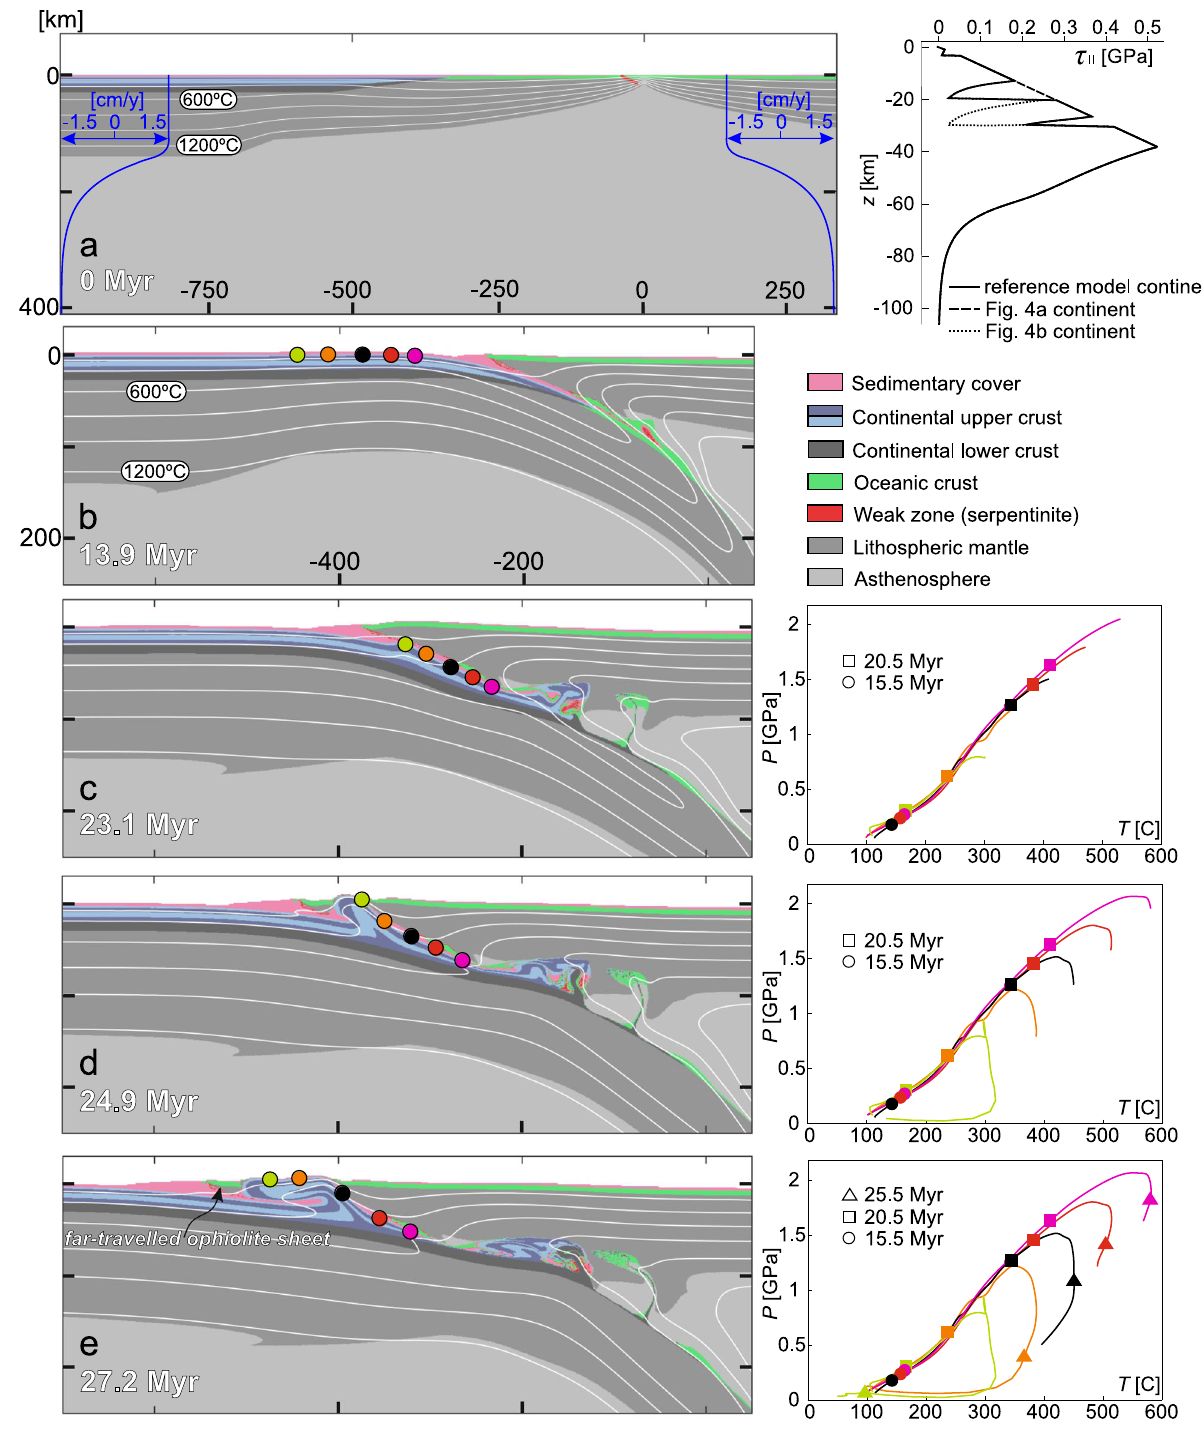
Fig. 2 Model setup and evolution of the reference model. The compositional evolution and associated P-T paths are presented in b – e on the left and right side, respectively. Colored circles are the positions of selected particles for recording P-T conditions and correspond to the colored lines on the left-side P-T diagrams. a Model setup showing the initial distribution of compositional domains, the velocity boundary condition, and the strength pro fi le (second stress invariant vs depth, assuming a transcurrent setting) for the continental domain. For thermal and rheological parameters of the model compositions see Table 1. Layering in the continental upper crust corresponds to passive strain markers. White lines are isotherms from 200 to 1200 °C. b Early-stage continental subduction at 13.9 Myr after the subduction of the left-side ocean between 0 and 10 Myr. c Late-stage continental subduction after the initiation of upper crustal decoupling. d Breaking of the oceanic upper plate and accelerated extrusion of the subducted upper crust. e Emplacement of the far- travelled ophiolite sheet further leftwards on top of the continent, dictated by crustal